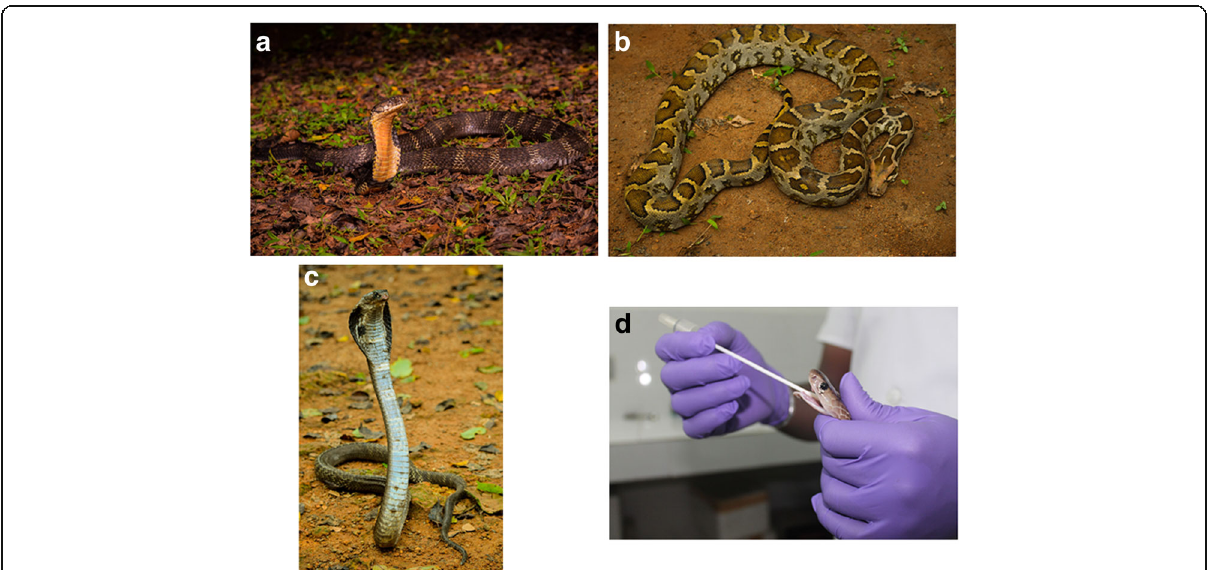
Fig. 1 Photographs of venomous and non-venomous species of snakes used for the oral sample collection. a King Cobra ( Ophiophagus hannah ); b Indian Python ( Python molurus ); c Indian Cobra (Naja naja ); d Oral sample collection from a snake using commercially available sterile cotton- tipped swab